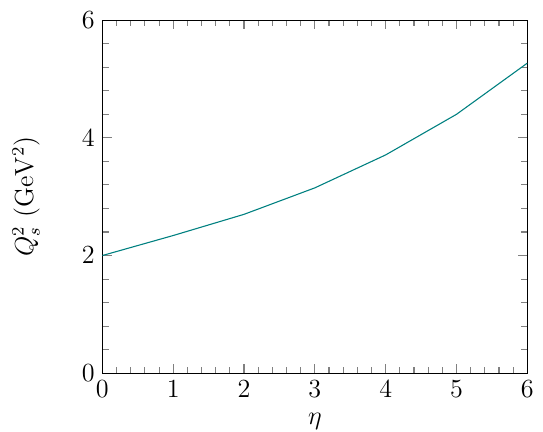
Figure 3. Rapidity dependence of the saturation momentum squared, as obtained by solving the collinearly resummed BK equation described in appendix D and with MV model initial condition with Q 2 = 2 GeV 2 s 0